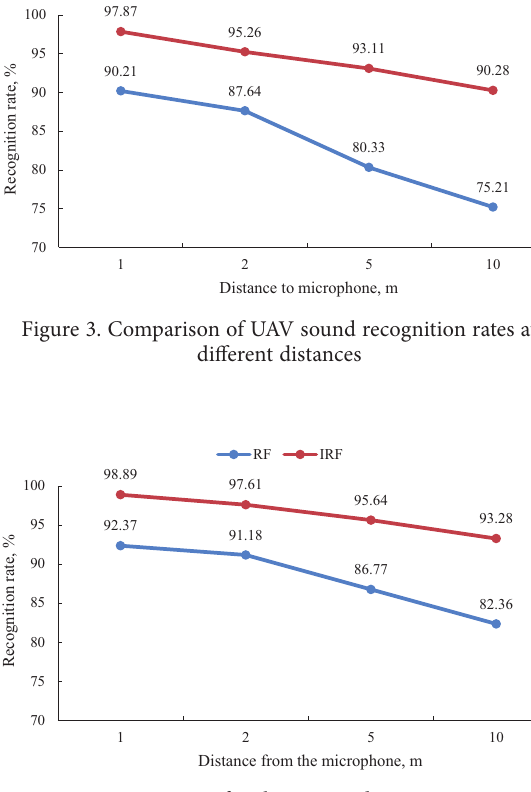
Figure 2. Comparison of the modeling time between two algorithms